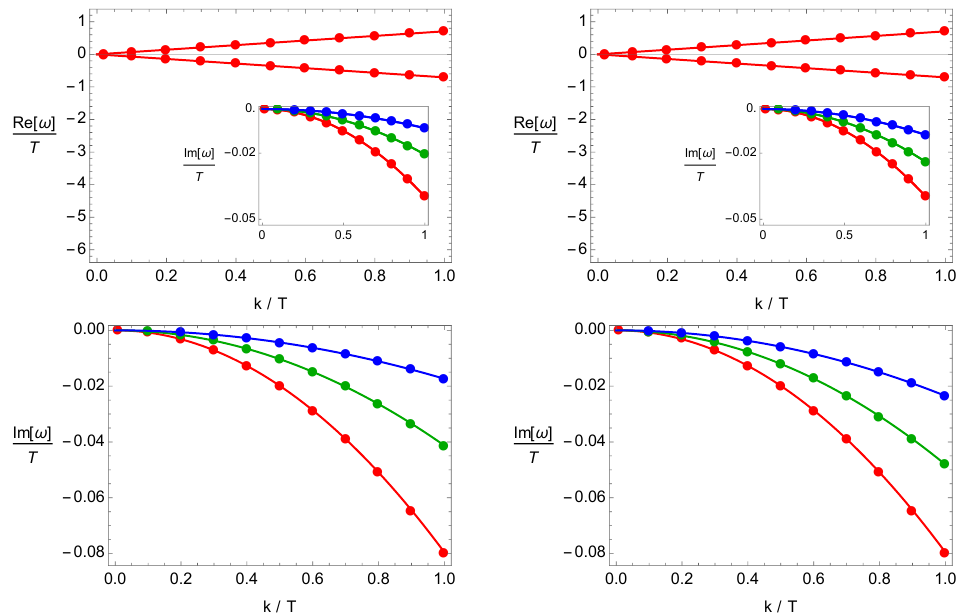
Figure 18 . Left: F 2 theory with Neumann boundary conditions; right: F 4 theory with Dirichlet boundary conditions. Top: sound waves. Bottom: shear diffusion. The colors correspond to B/T 2 = 10 − 6 , 40, 150 (red, green, blue).